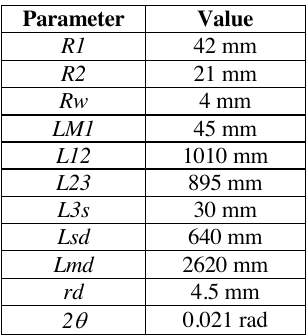
Table 1. Parameters in Fig.1 for r-SANS experiment Parameter